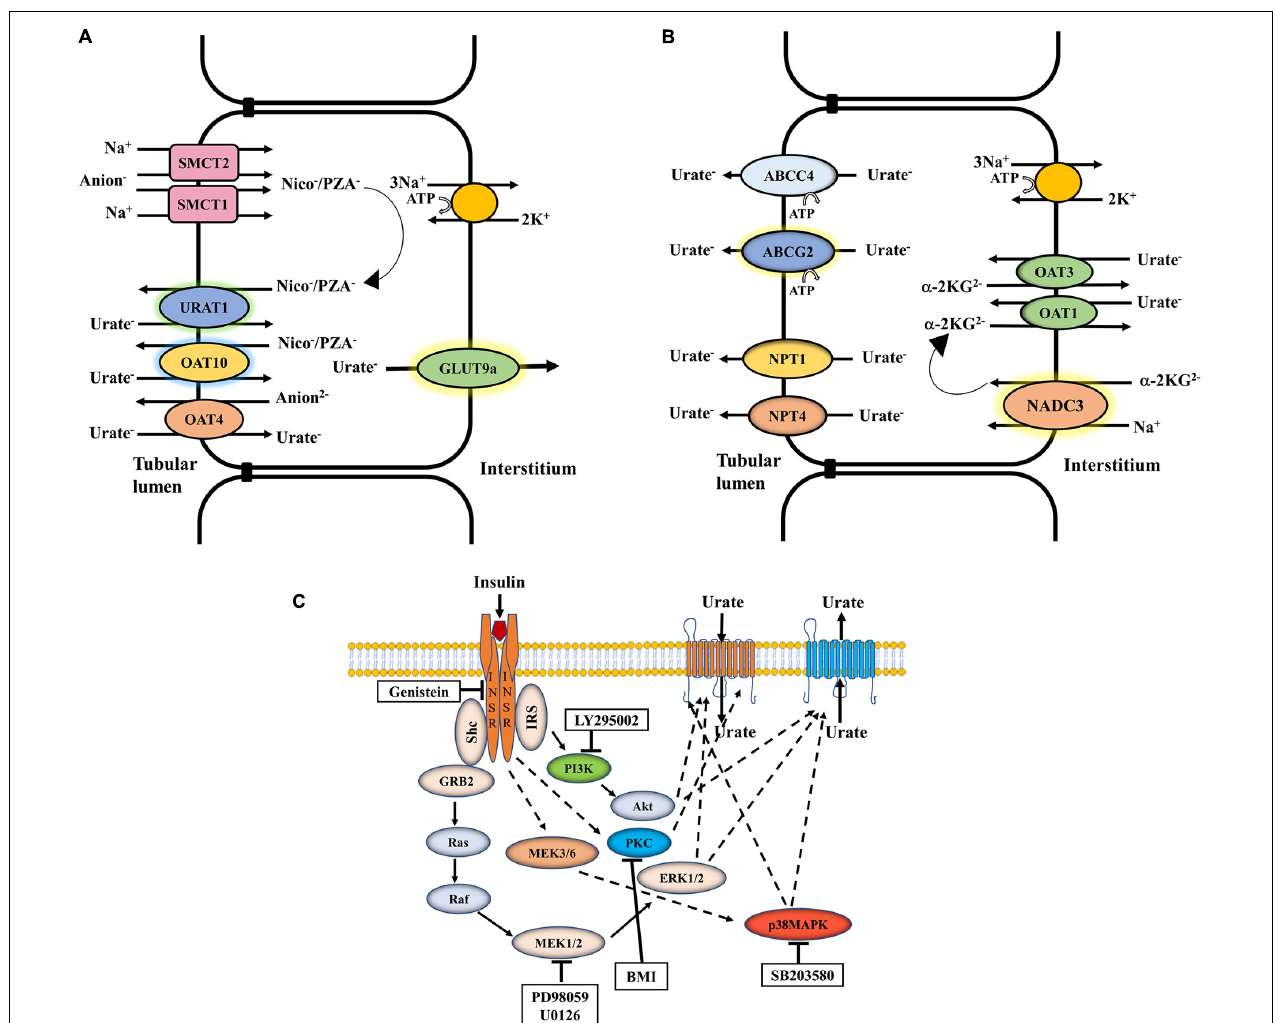
FIGURE 1 | The net excretion of urate in the human urine depends on the balance between urate reabsorption and secretion, mediated by separate sets of urate transporters in the proximal tubule. (A) Urate reabsorption: The sodium-driven SMCT1 and SMCT2 transporters increase the intracellular pool of organic anions such as nicotinate or pyrazinoate (PZA), which function in urate/anion exchange mediated by URAT1 and OAT10. OAT4 in contrast exchanges apical urate for divalent anions. The membrane potential-driven GLUT9a functions as the exclusive exit pathway for reabsorbed urate from proximal tubule into blood. (B) Urate secretion: In a sodium dependent process involving the collaboration of NADC3, urate enters at the basolateral membrane in exchange with alpha-ketoglutarate, mediated by OAT1 and OAT3. Urate is transported across the apical surface into the tubular lumen via MRP4, ABCG2, NPT1, and NPT4. (C) Regulation of urate transport by insulin signaling: Insulin binding to its receptor (INSR) leads to the activation of insulin receptor substrate (IRS), Akt, ERK1/2, p38 MAPK and PKC. The general effect of insulin on urate transport (reabsorption or secretion) is indicated. Genistein, a phosphotyrosine kinase (PTK)-specific inhibitor; LY 295002, a PI3K-specific inhibitor; PD98059, a MEK/ERK-specific inhibitor; SB 203580, a p38 MAPK-specific inhibitor; BMI, bisindolylmaleimide 1-hydrochloride, a protein kinase C (PKC)-specific inhibitor.